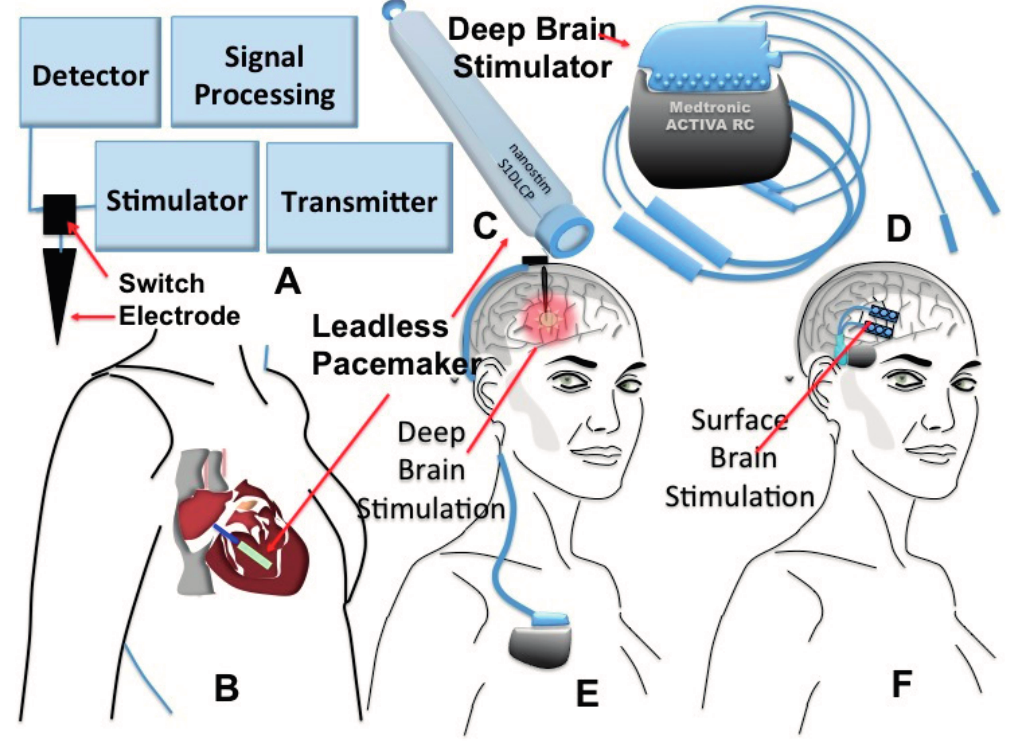
Figure 2. State of the art implantable devices for brain POC applications: ( A ) simplified diagram of implantable system; ( B ) the schematic of new wireless pacemaker placed in the heart; ( C ) the photo of this leadless pacemaker commercialized by Nanosim Inc.; ( D ) brain stimulator commercialized by Medtronics for epilepsy point-of-care purposes implanted; ( E ) under the skull for surface brain stimulation or ( F ) the stimulator placed above the chest for deep brain